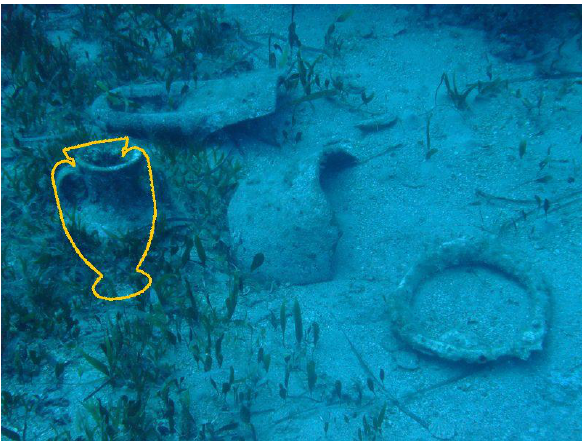
Figure. 11. Results of shape detection for Fuzzy Logic algorithm